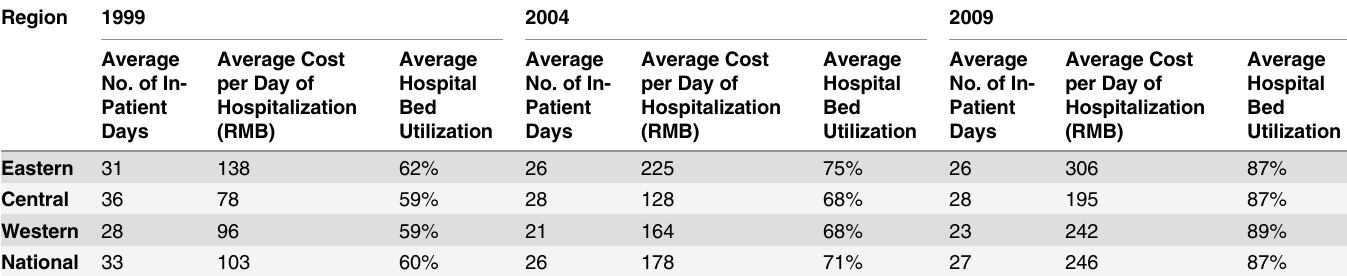
Table 3. Breakdown of hospital bed usage, per